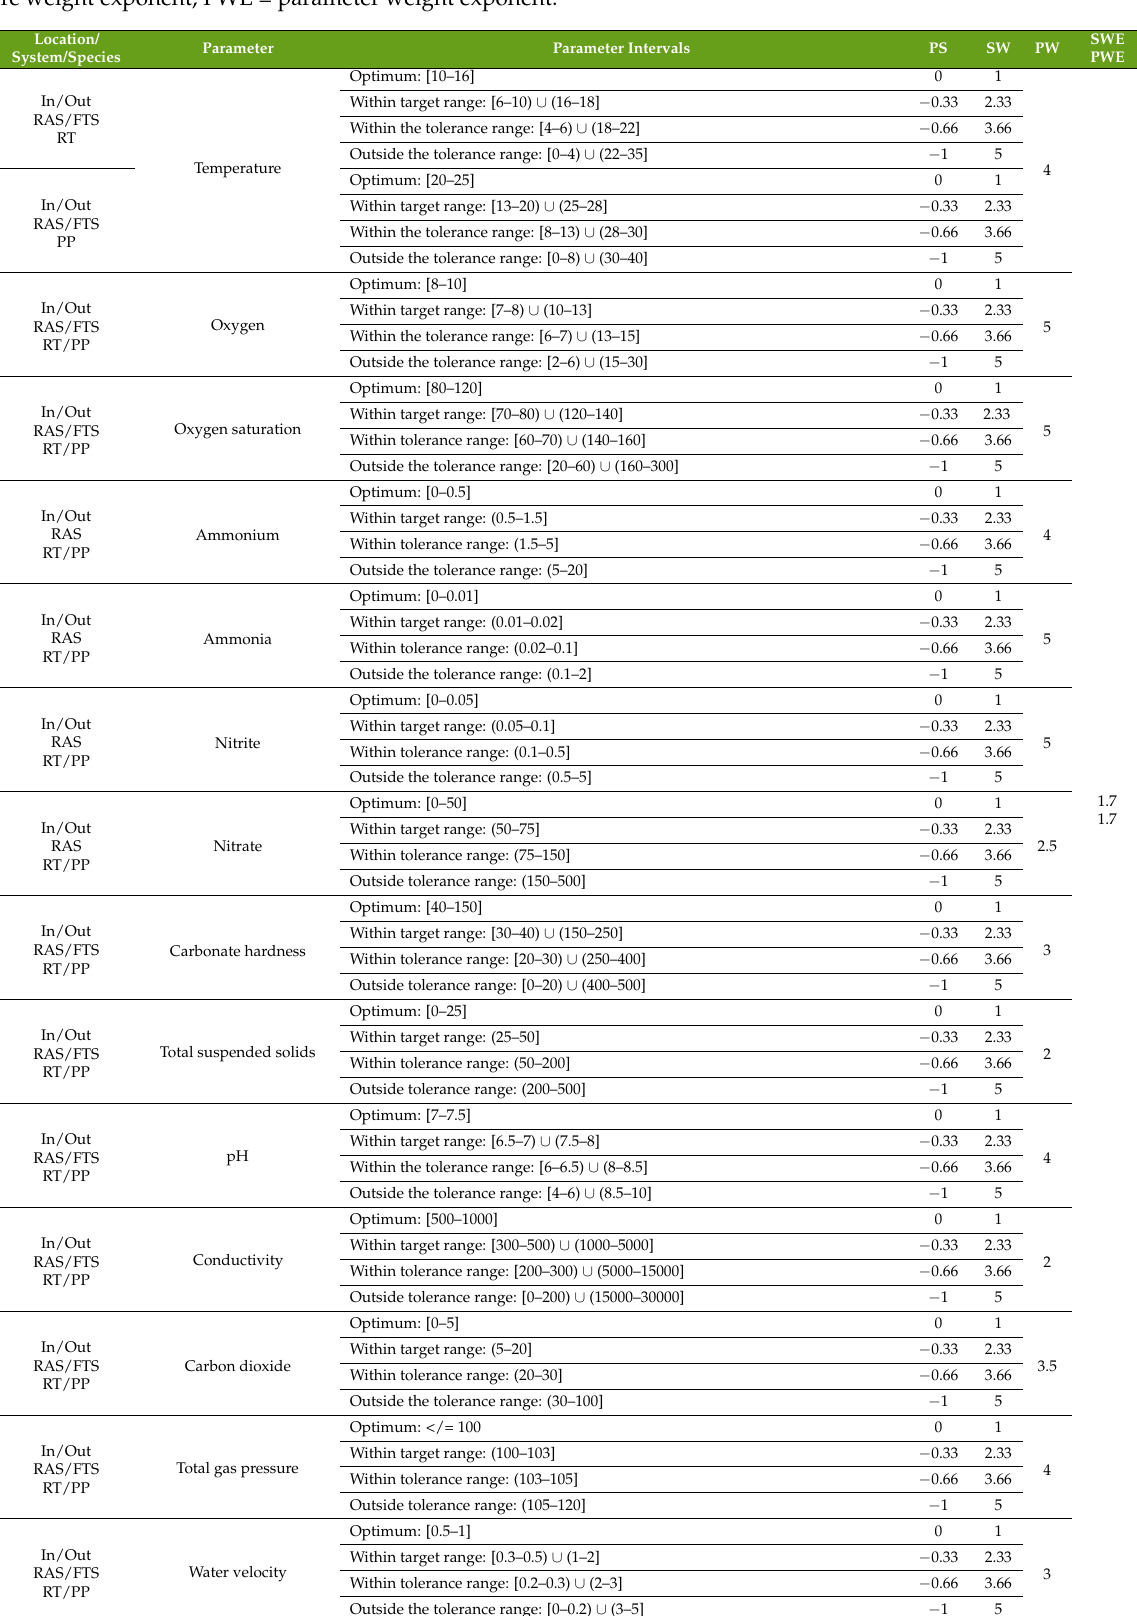
Table A2. Module water quality. In = indoor, Out = outdoor, RAS = recirculating aquaculture system, FTS = flow-through system, RT = rainbow trout, PP = pikeperch, PS = parameter score, SW = score weight, PW = parameter weight, SWE = score weight exponent, PWE = parameter weight